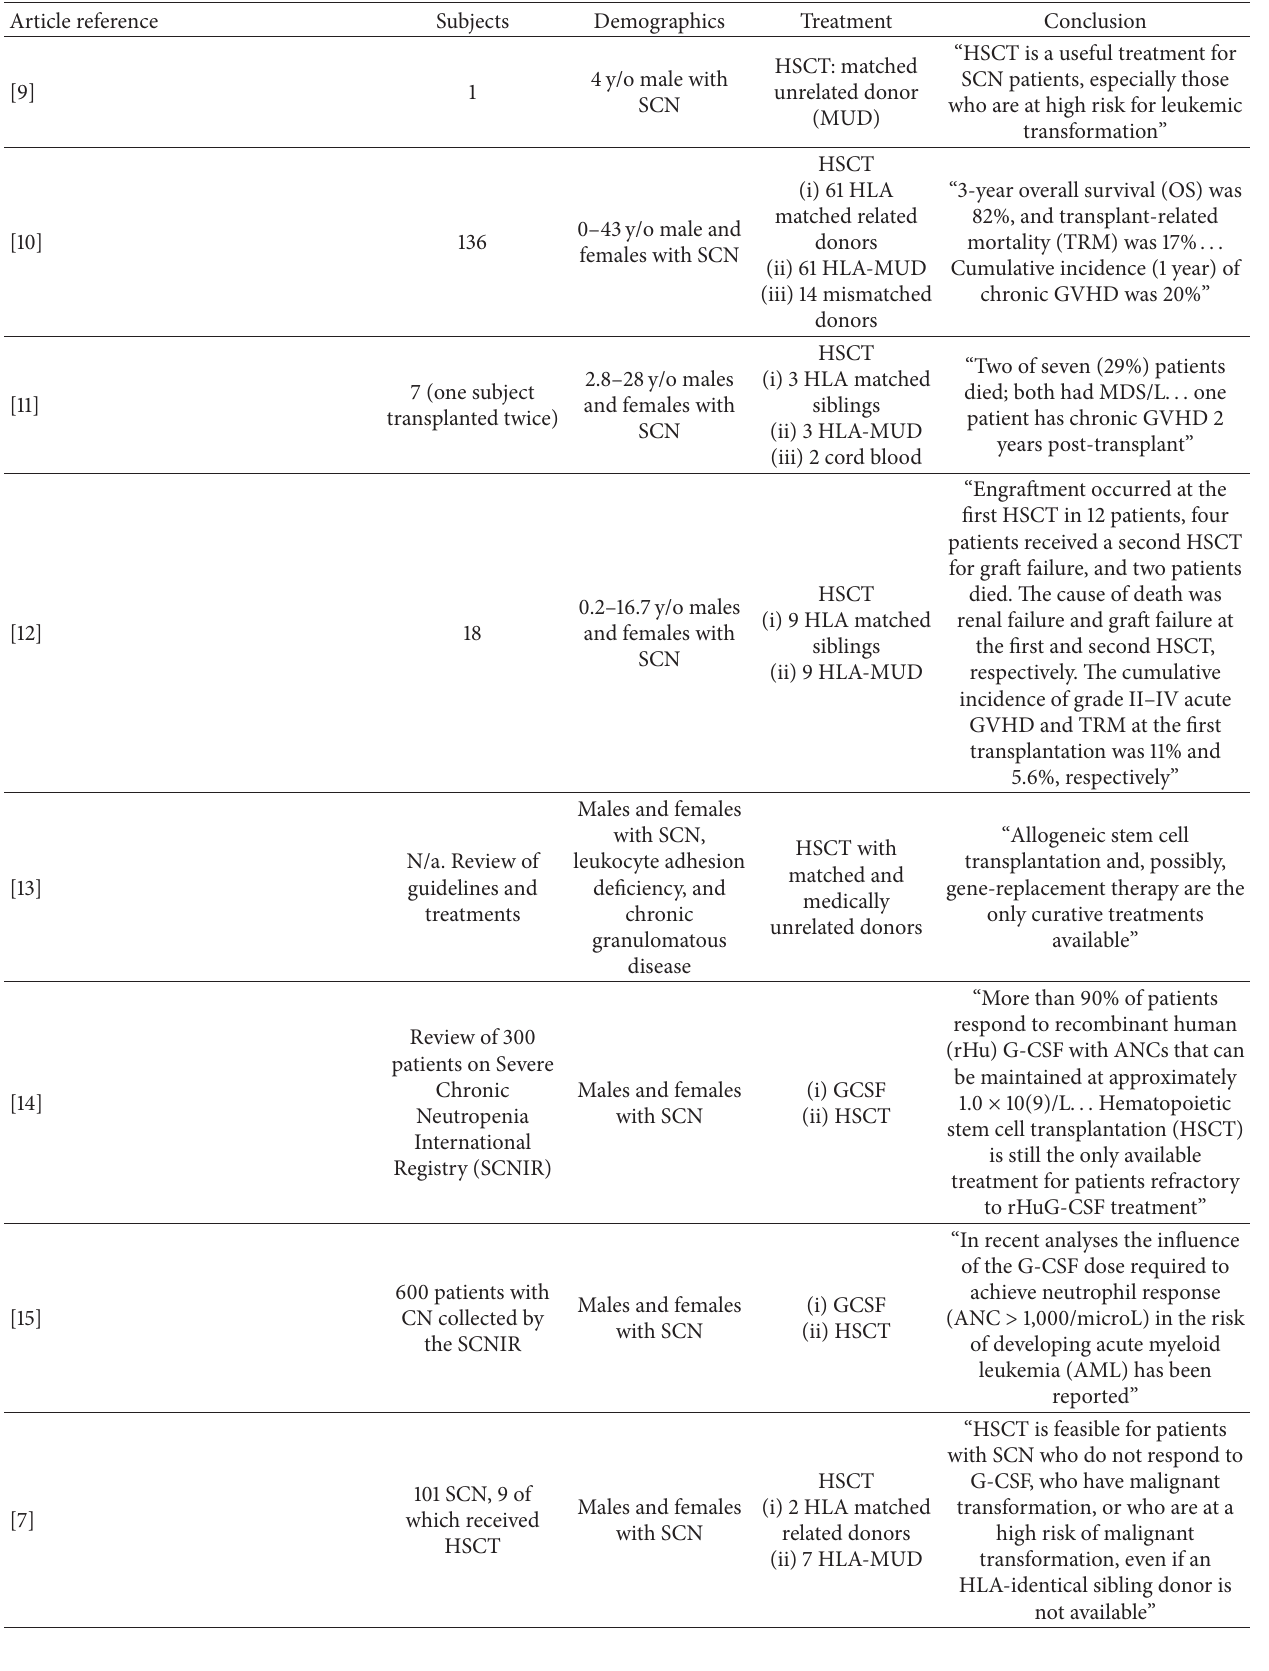
Table 2: Summary of relevant literature of SCN and